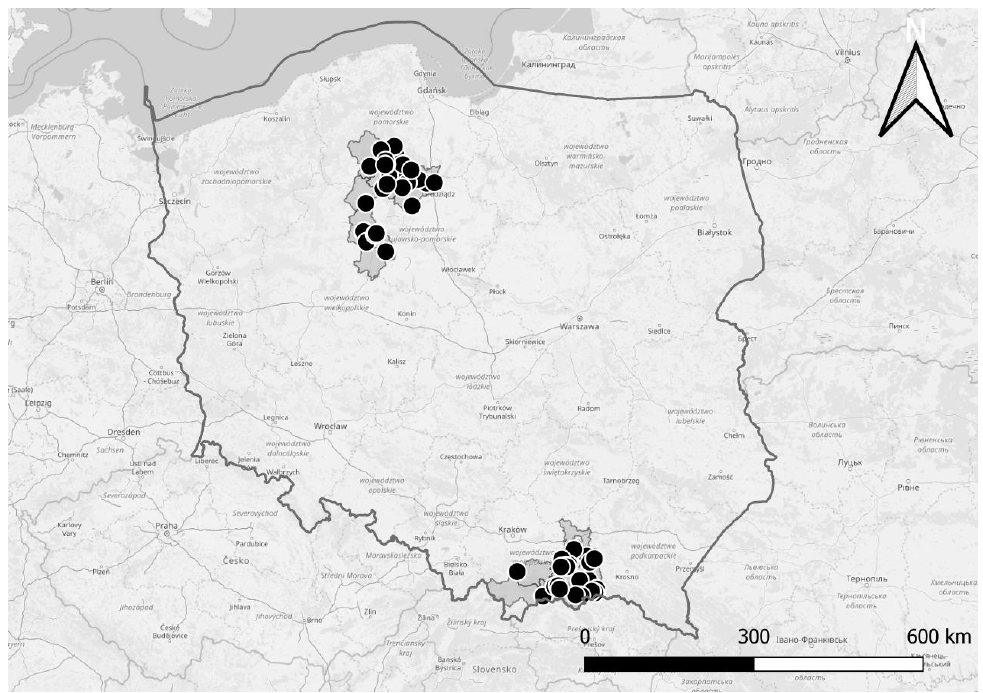
Figure 2. Location of forest sales within the study areas. Source: own elaboration.